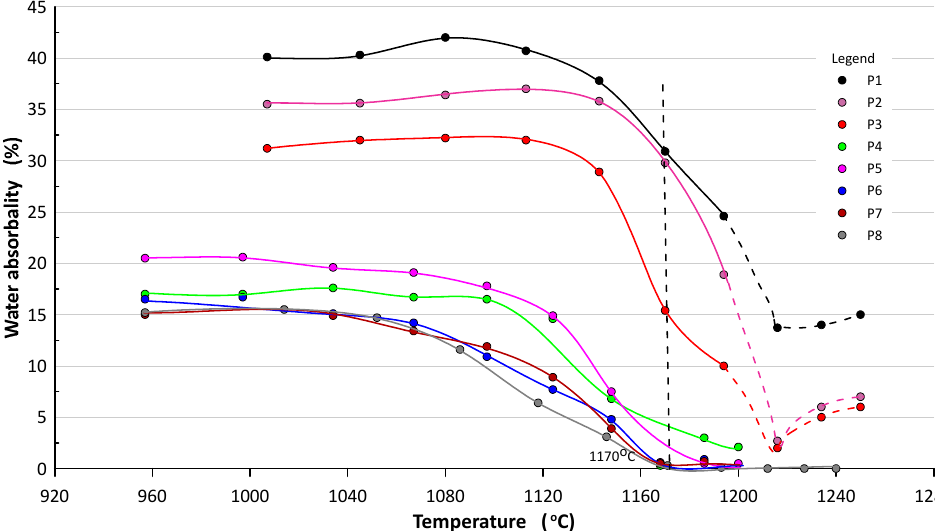
Figure 6. Changes in the water absorbability of ceramics as a function of firing temperature.